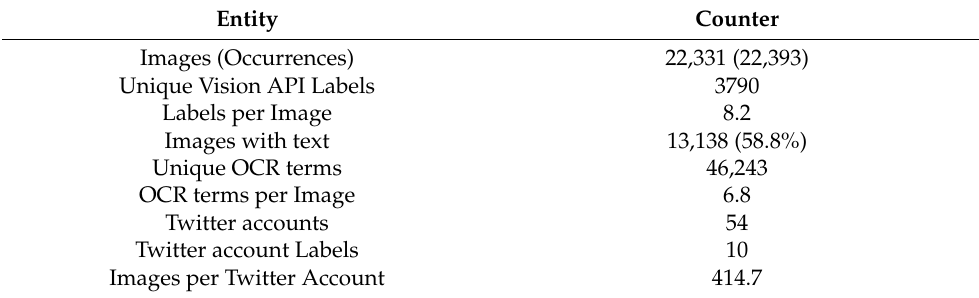
Table 3. Celebrities dataset